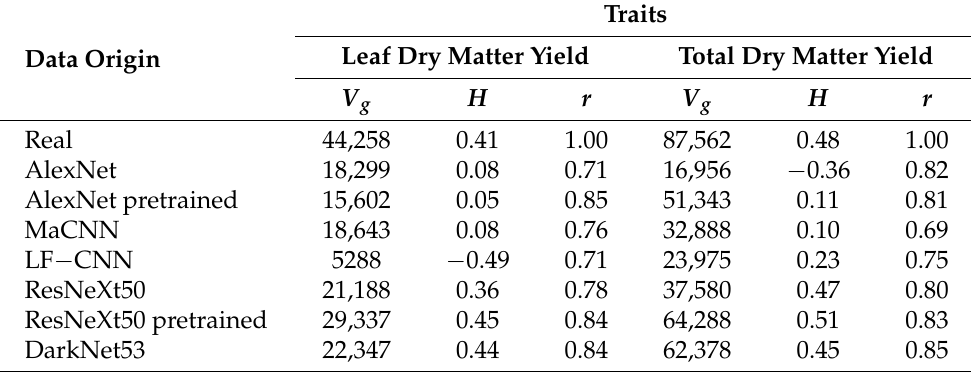
Table 6. Genetic parameters for dry matter traits in the guineagrass breeding program using field data and their estimates by several CNNs architectures. V g -Genetic variance among full-sib families; H-broad sense heritability; r-approximate genetic correlation between real and HTP